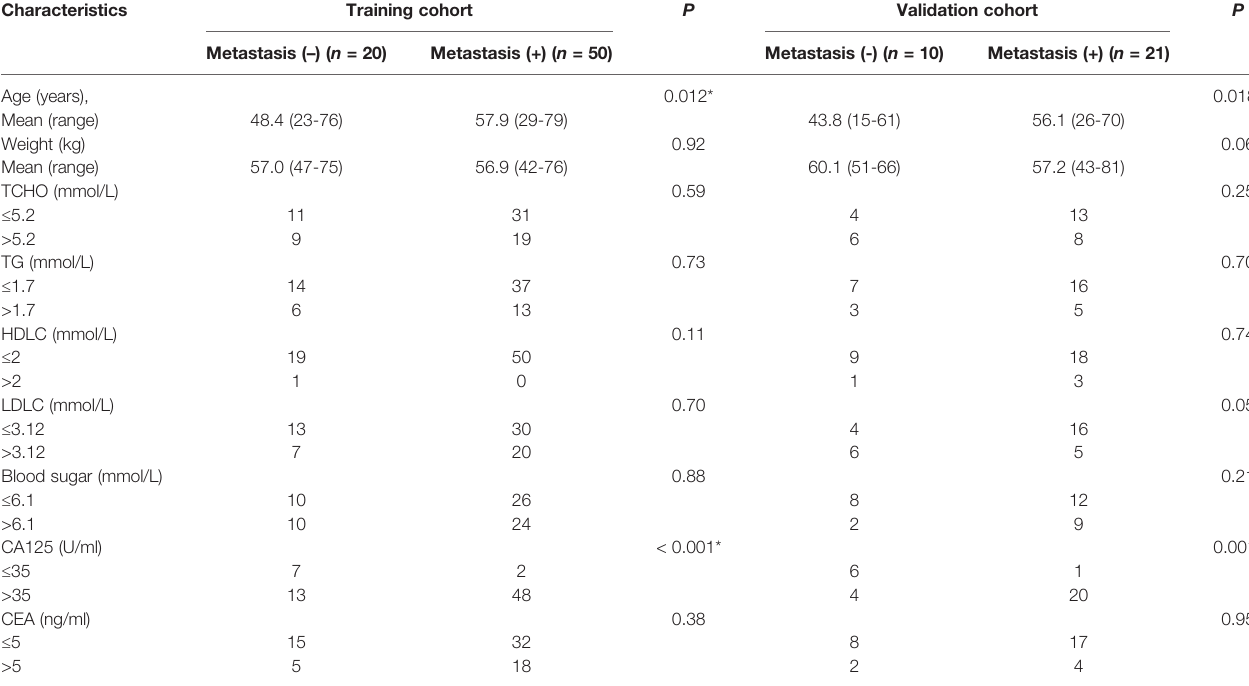
TABLE 3 | Univariate analysis of preoperative clinical factors associated with metastasis.